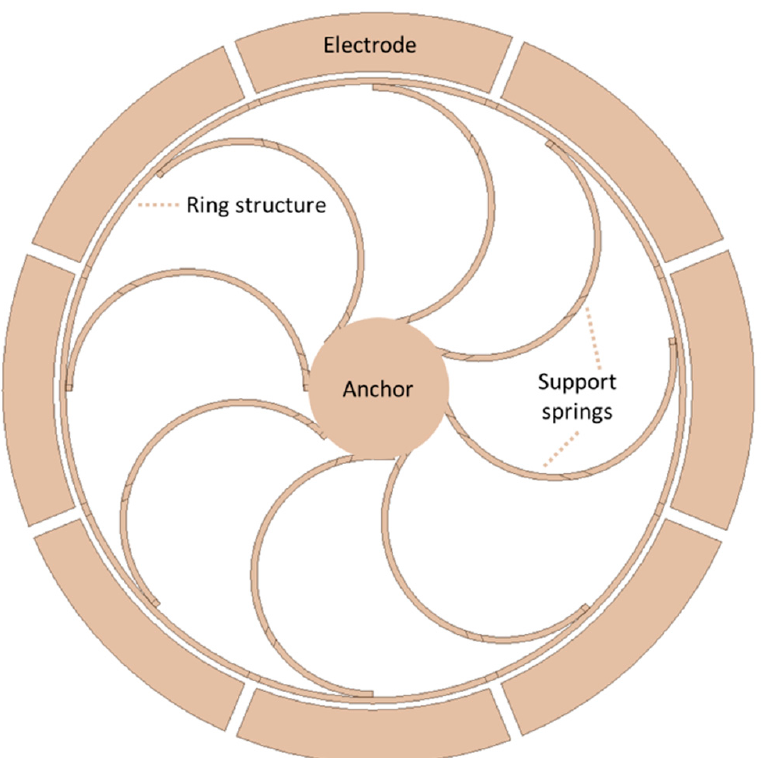
Figure 15. Schematic view of a novel vibrating ring gyroscope developed by General Motors. In 1998, a research group at the University of Michigan reported the first development of a micromachined polysilicon vibrating ring gyroscope [49]. The ring structure was 30